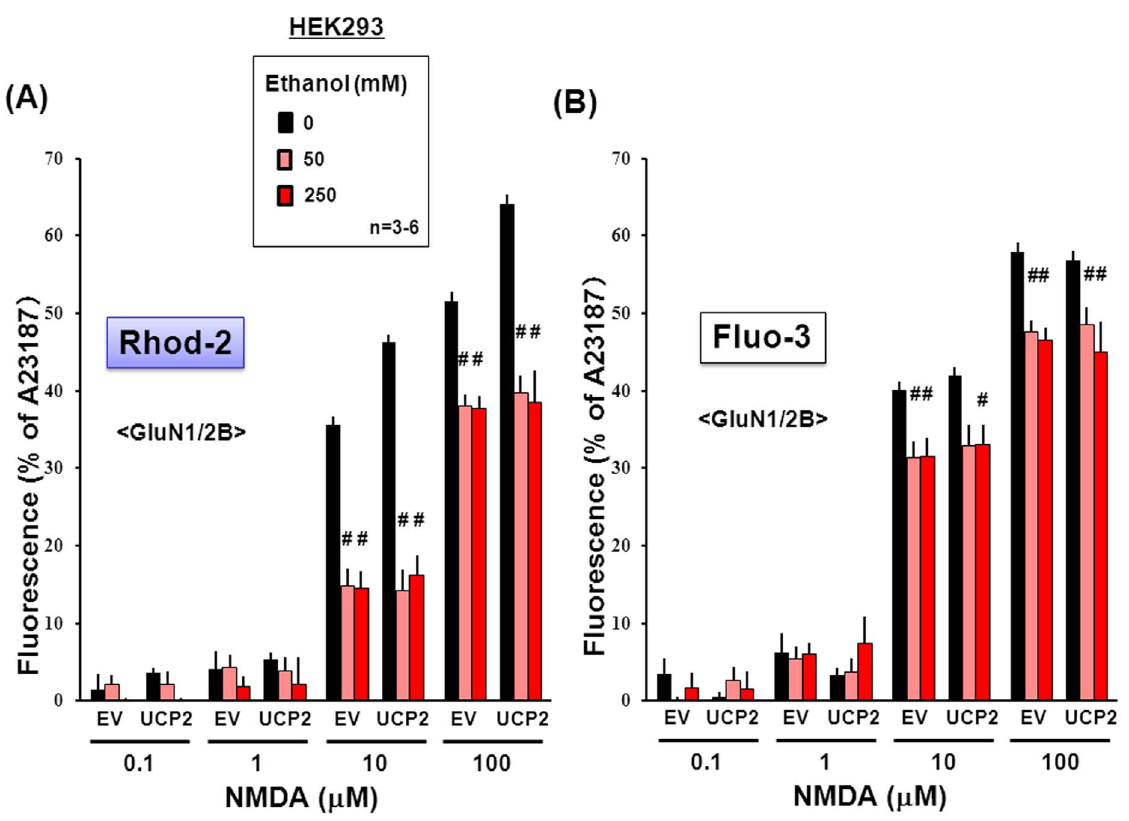
Figure 8. Effects of ethanol on Rhod-2 and Fluo-3 fluorescence in HEK293 cells with GluN1/GluN2B subunits. HEK293 cells were transfected with expression vectors of GluN1 and GluN2B subunits along with Flag-UCP2, followed by further culture for an additional 24 h and subsequent loading of either (A) Rhod-2 or (B) Fluo-3. Cells were cumulatively exposed to NMDA at 0.1 to 100 m M in either the presence or absence of ethanol at different concentrations. Values are percentages over the maximal fluorescence by A23187 in 3–6 independent determinations. # P , 0.05, significantly different from the value obtained in cells not exposed to ethanol. Statistical significance was determined according to 2-way ANOVA test